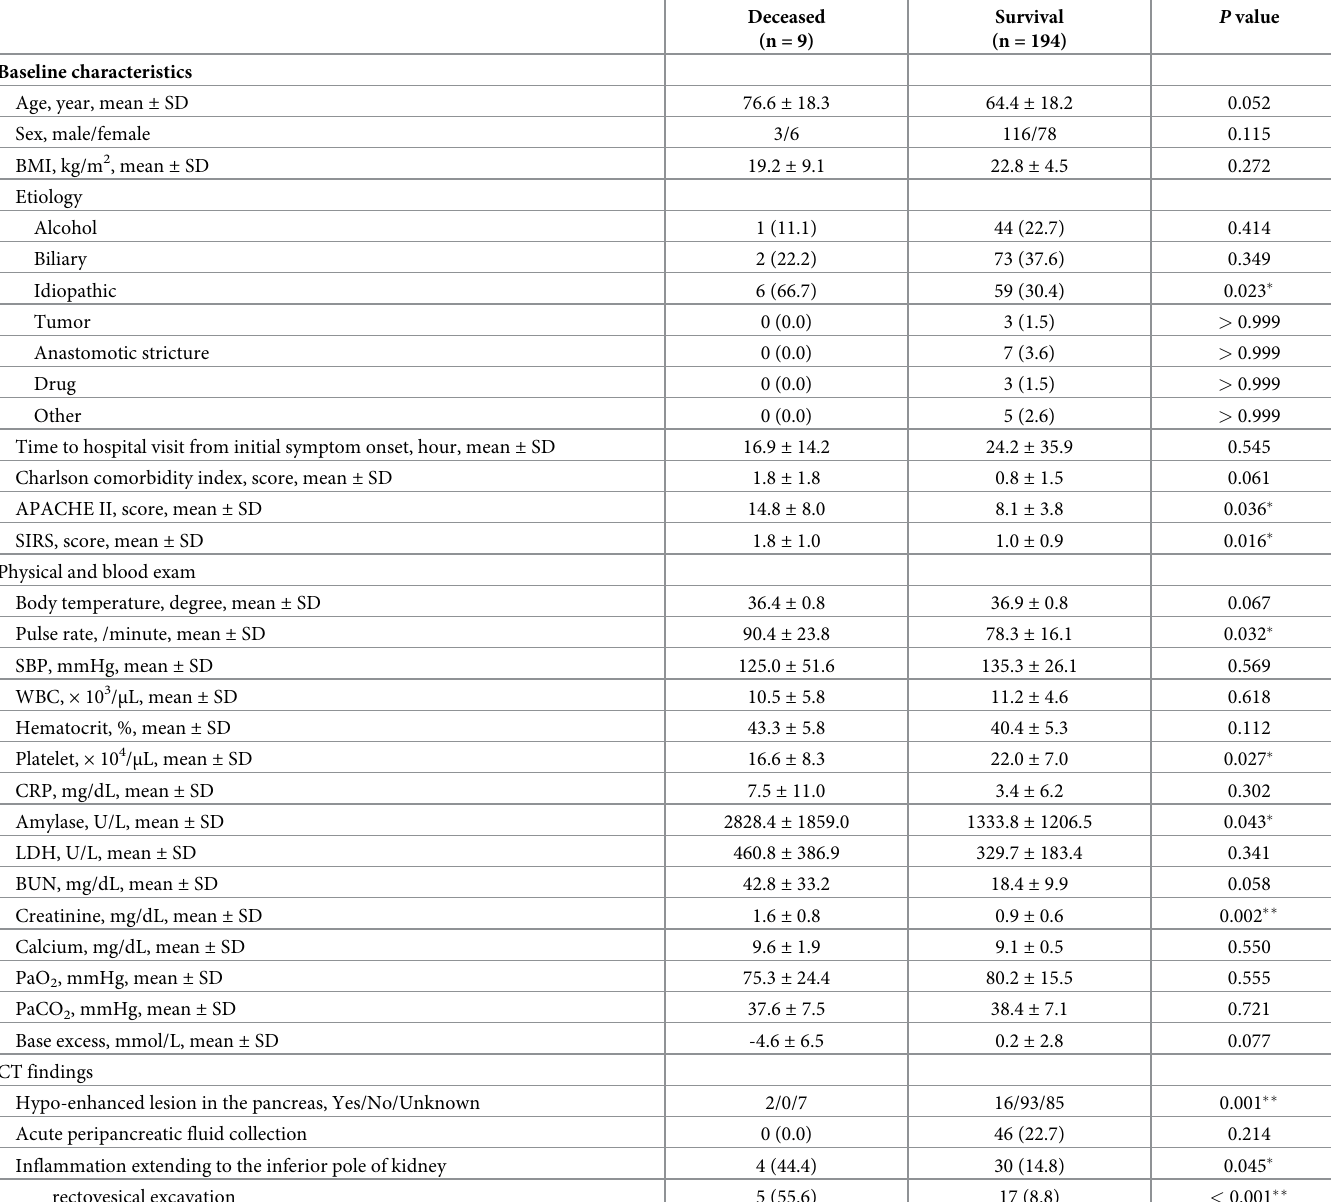
Table 3. Comparison of deceased and survival patients on admission (n =